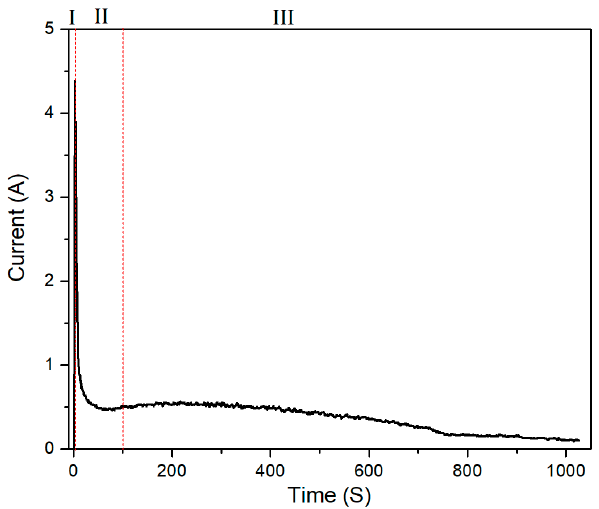
Figure 3. Cell current density-versus-time responses during PEO treatments of the Ti6Al4V alloy.